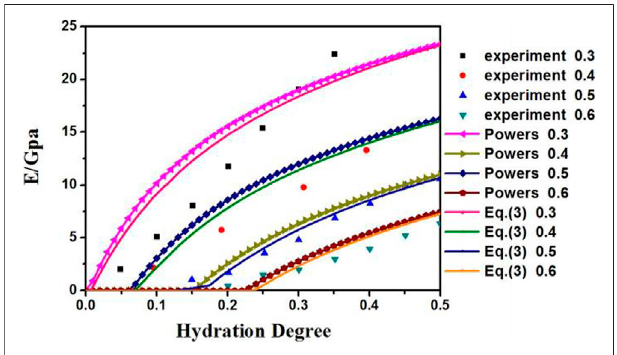
FIGURE 6 | Elastic modulus based on Powers ’ s model, Eq. 3 , and experimental results of Boumiz et al. (1996) for different w/c